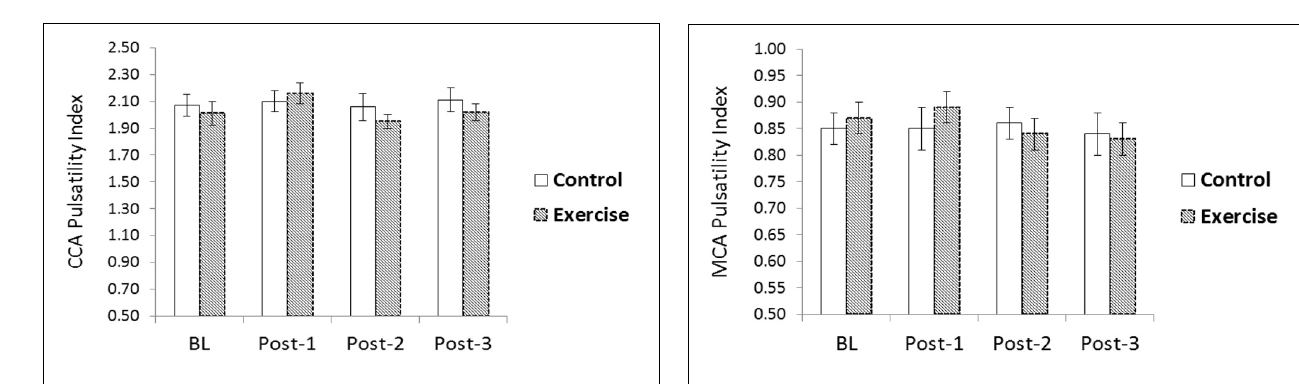
FIGURE 2 | Common carotid artery (CCA) blood flow velocity pulsatility index (PI) following acute resistance exercise (RE) vs. a time control condition. No significant changes were noted ( p > 0 . 05).